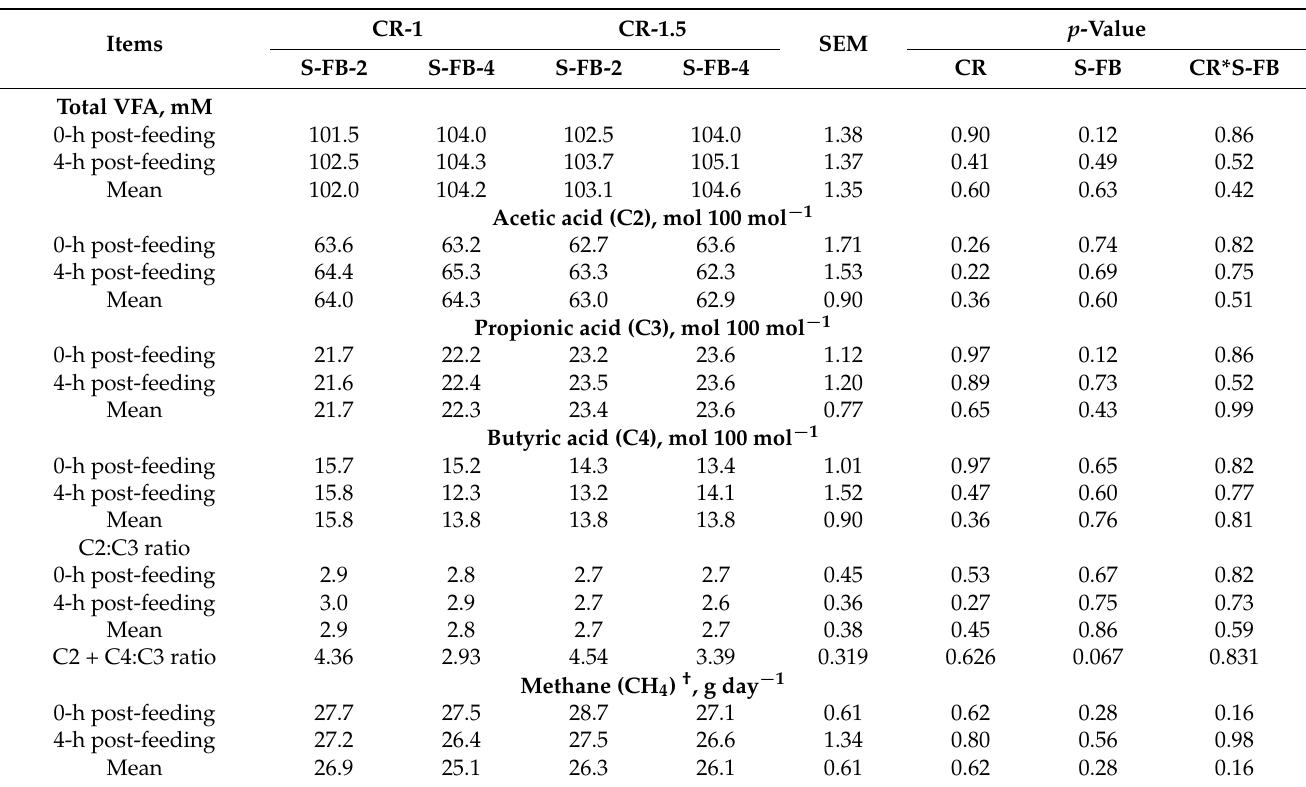
Table 4. Effect of fresh cassava root (CR) and solid feed-block containing high sulfur (S-FB) on ruminal volatile fatty acid (VFA) and methane estimation (CH 4 ).